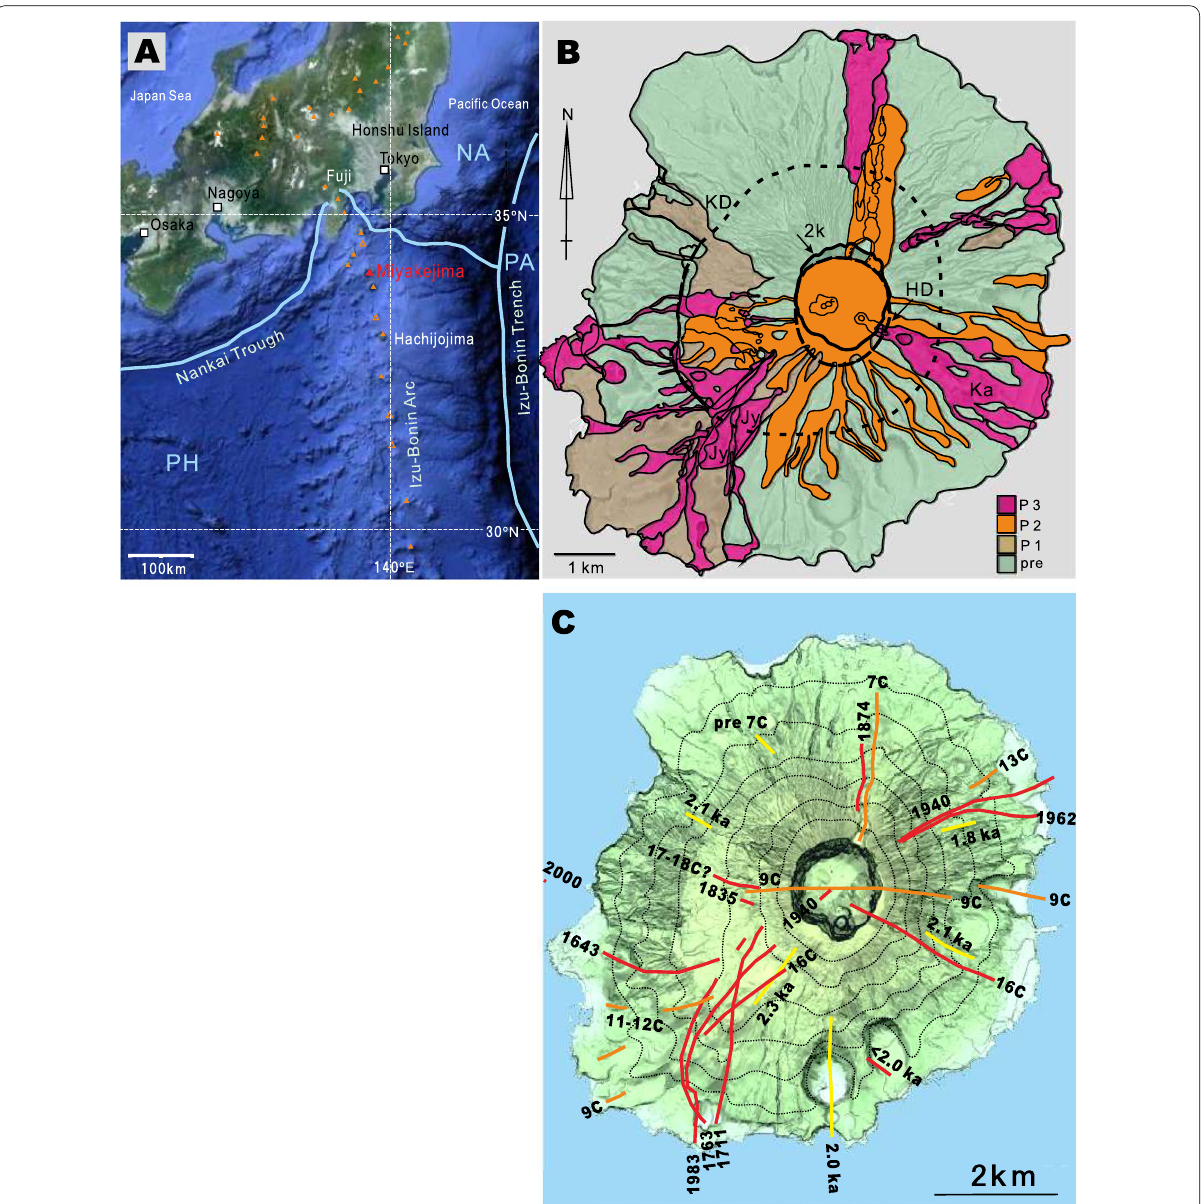
Fig. 1 A Location map of Miyakejima volcano. Broad blue lines show the plate boundary. PH Philippine Sea Plate, PA Pacific Plate, NA North American Plate. Orange triangles show the location of active volcanoes. Background image is after Google Earth. B Simplified geological map of Miyakejima volcano. Broad black lines show the topographic rim of Kuwanokidaira caldera (KD), Hatchodaira caldera (HD), and the 2000 AD caldera (2k). Dotted line is the buried caldera rim of Kuwanokidaira and Hatchodaira calderas. Pre: edifice of pre-Hatchodaira caldera (older than ~ 2.3 ka). P1: distribution of the deposits of Period 1. P2: the deposits of Period 2 (from seventh to fourteenth century). P3: the deposits of Period 3 (from sixteenth century to present). Distribution of Jinanyama scoria cone and Kamakata lavas are indicated by Jy and Ka, respectively. C Distribution of the representative eruption fissures of Period 1 (yellow), Period 2 (orange) and Period 3 (red). Due to the cover of the younger deposits, not all the eruption fissures are